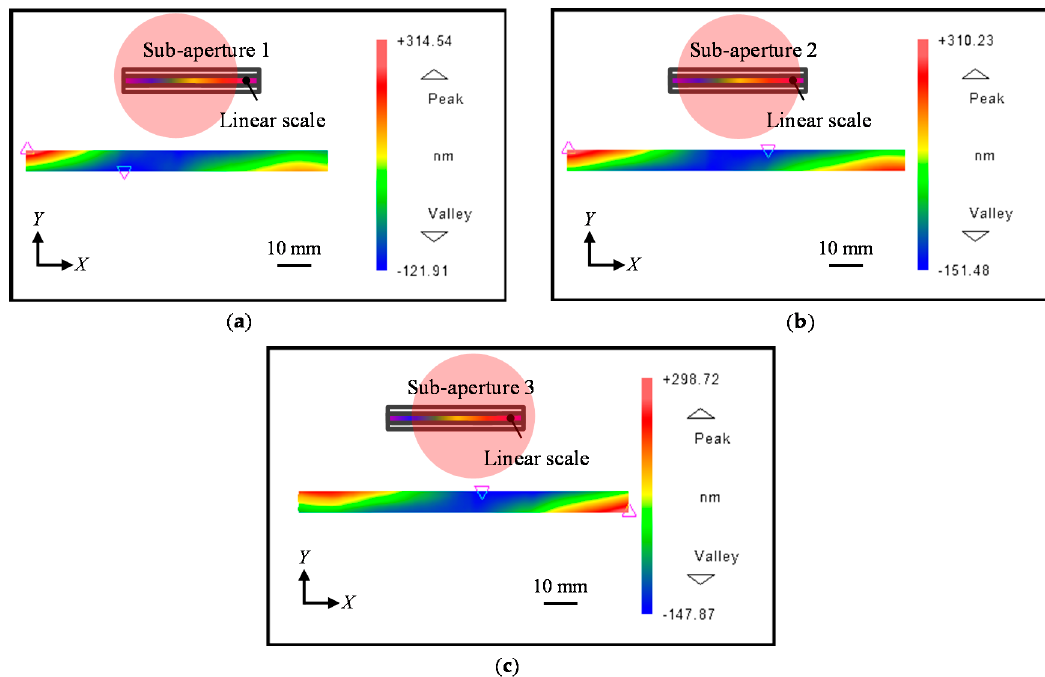
Figure 11. Measured negative first-order diffracted wavefront from the linear scale grating. ( a ) X -directional negative first-order diffracted beam from Sub-aperture 1; ( b ) X -directional negative first-order diffracted beam from Sub-aperture 2; ( c ) X -directional negative first-order diffracted beam from Sub-aperture 3.